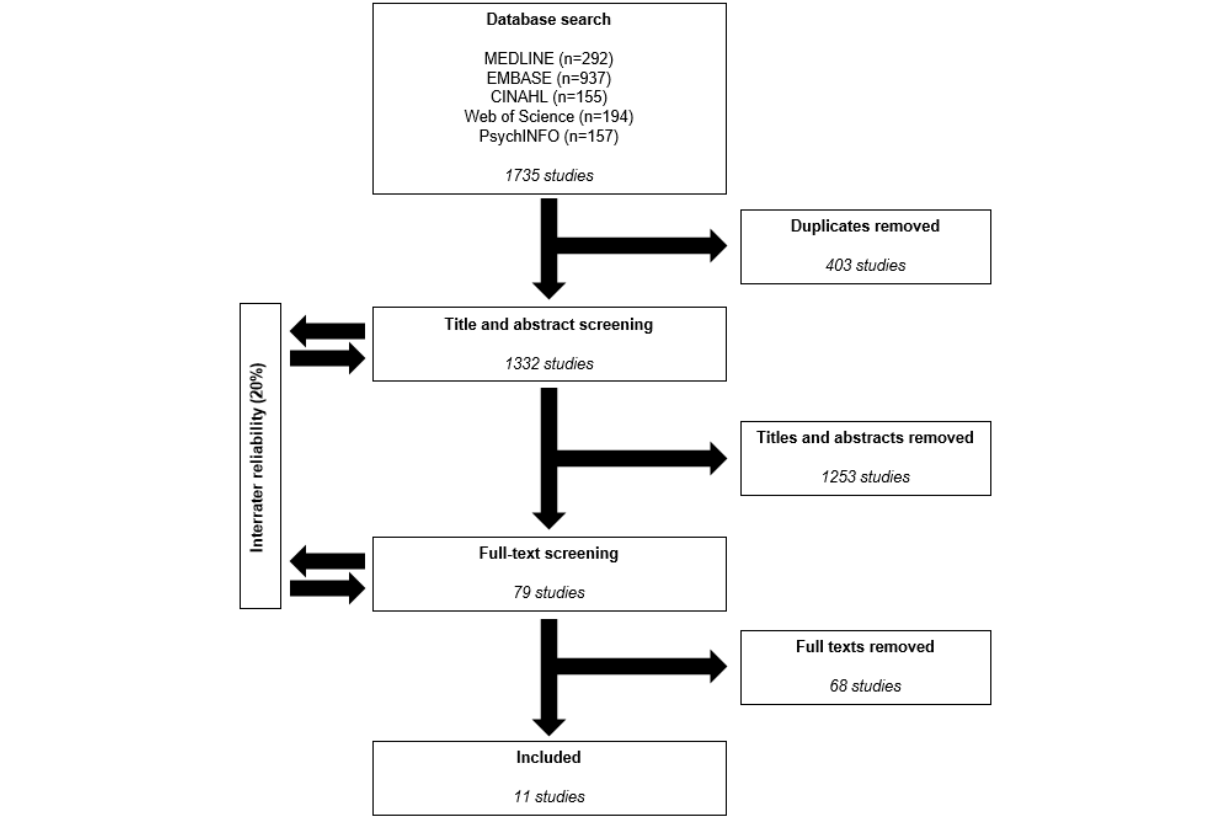
Figure 1. Summary of literature search